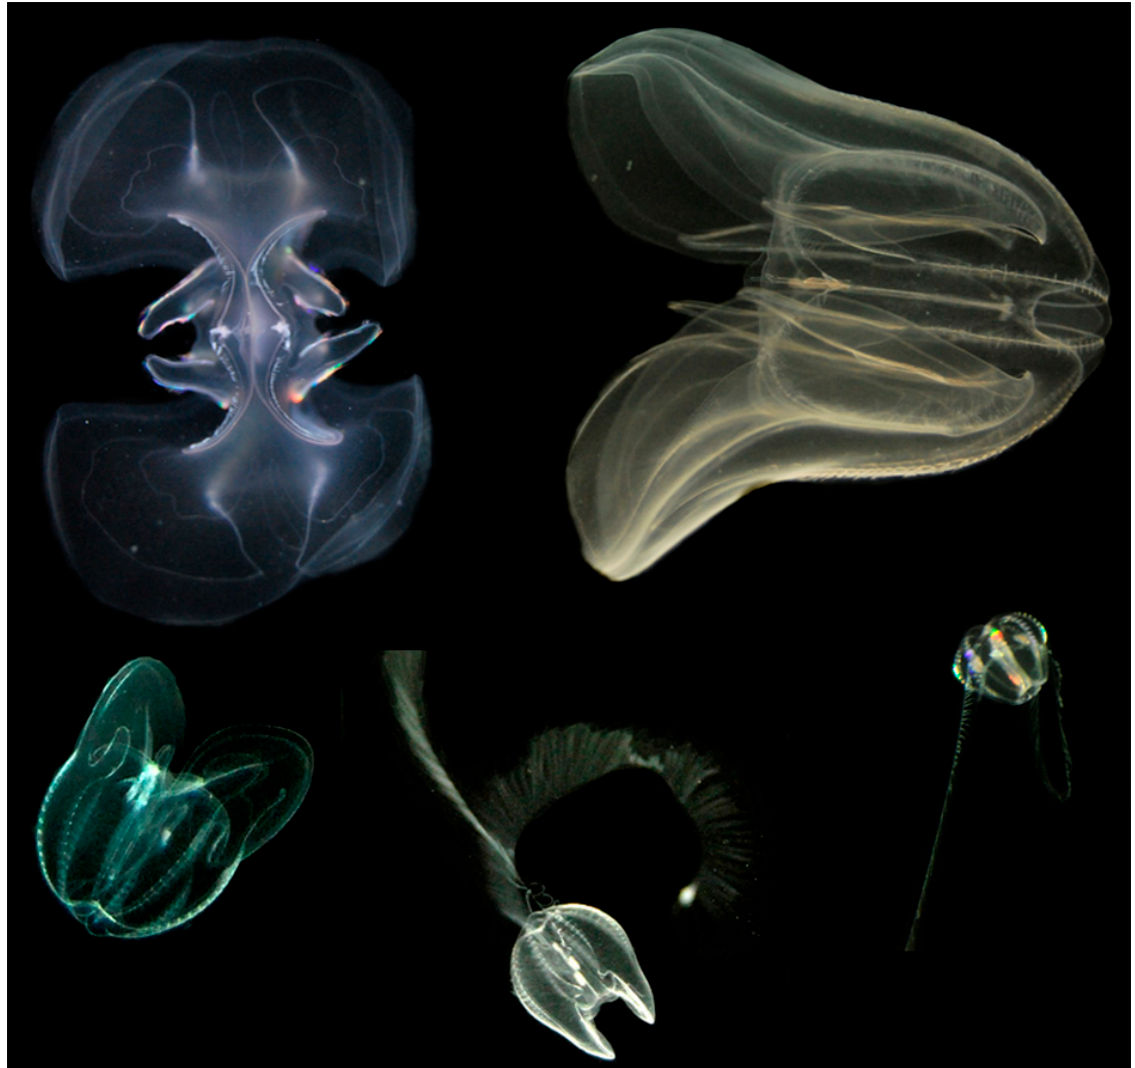
Figure 7. Non-indigenous comb jelly Mnemiopsis leidyi with holoplanktonic development sequence. Newly hatched larvae (0.5–1 mm, bottom right), larvae with developing lobes (2.5 mm, centre), transitional stage with reduced tentacles (5–6 mm, left) and adults with oral (left) and vertical (right) view, ca. 20 mm oral-aboral length. Image credit: C. Jaspers.